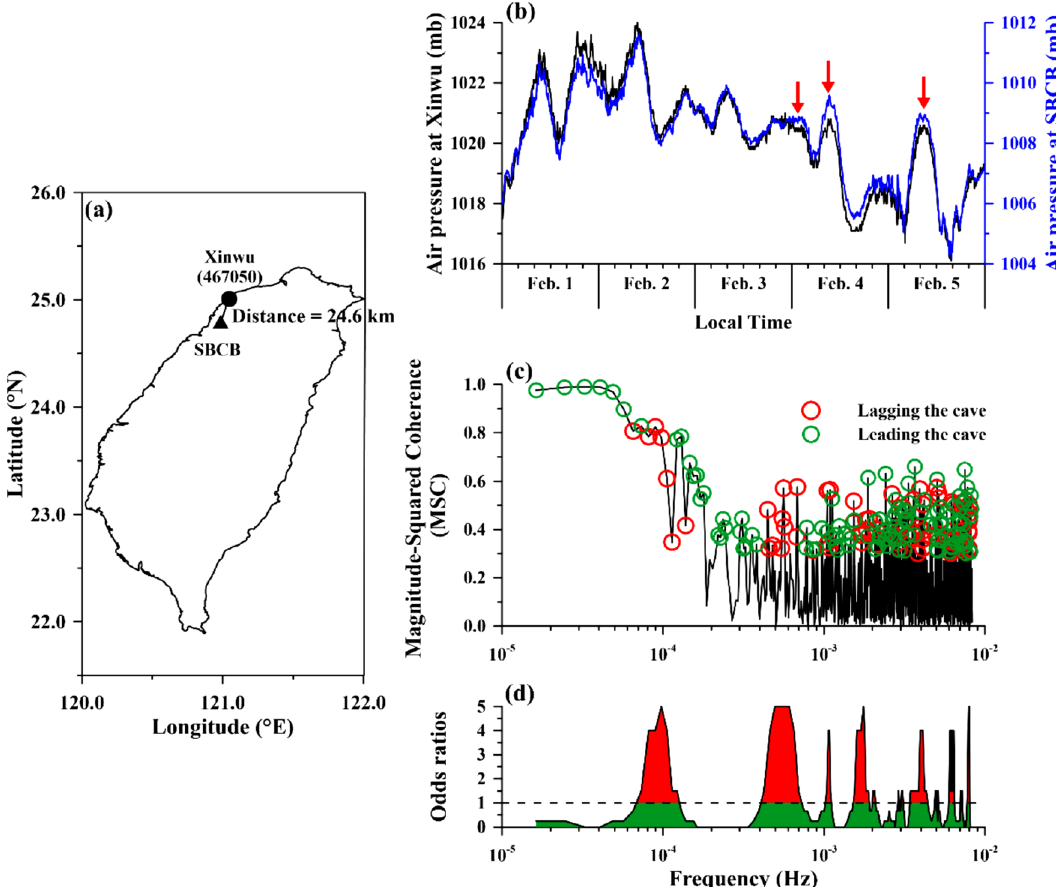
Figure 1. Locations and analytical results of air pressure data at Xinwu and SBCB stations. The locations of the two stations are shown in ( a ). The variations in air pressure during February 1–5 in 2016 are shown in ( b ). Black and blue lines denote the variations in air pressure at Xinwu and SBCB stations, respectively. Red arrows indicate the amplified variations in air pressure in the cave at SBCB station. The Magnitude-Square Coherence (MSC) varied with frequency that is shown in ( c ). Green (red) open circles denote changes in air pressure at Xinwu station that lead (lag) to variations in the cave at SBCB station by utilizing the phase angle at each frequency. ( d ) The statistical results of the leading values with a coherence > 0.35 determined by the odds test with a moving window of 5